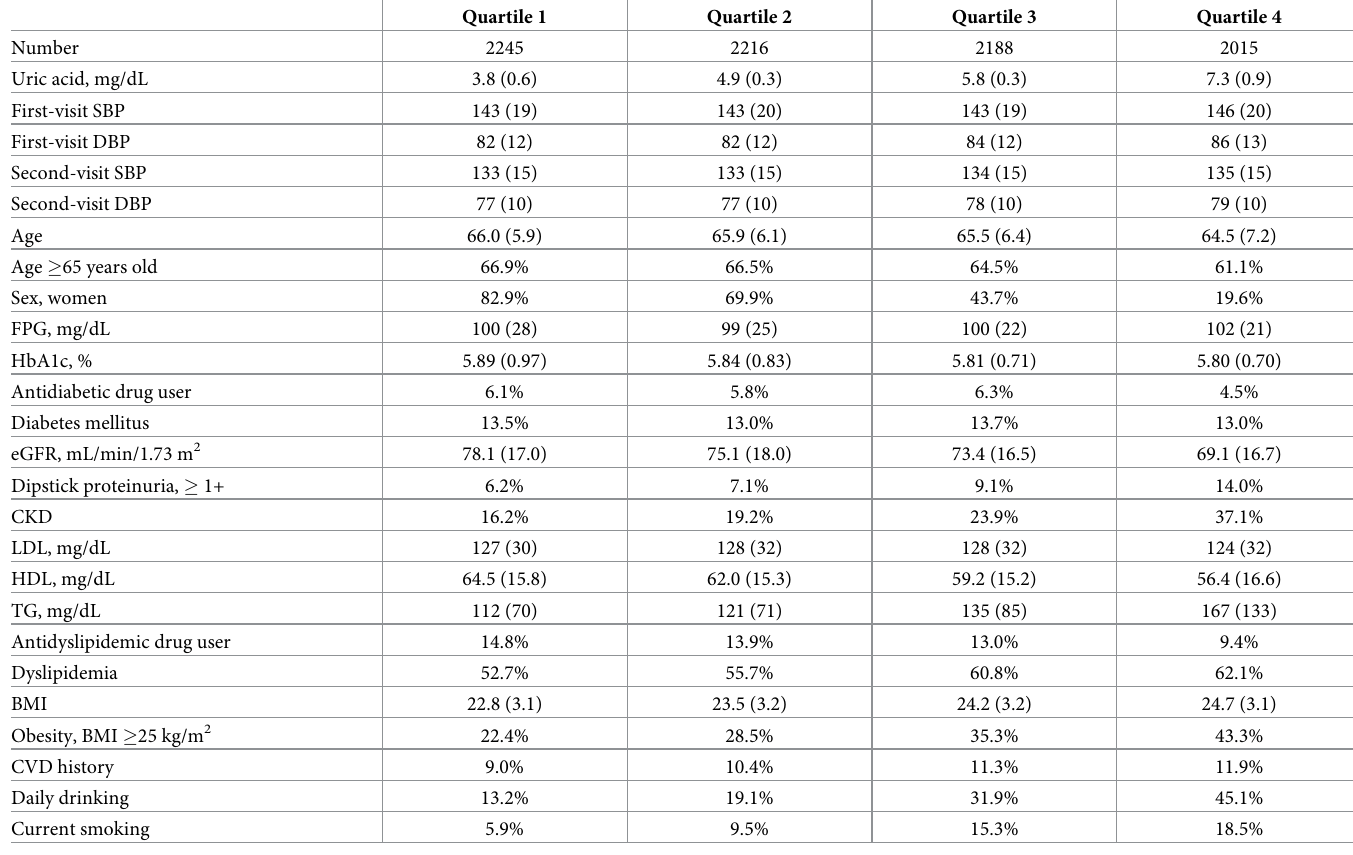
Table 1. Comparison between quartiles based on baseline uric acid